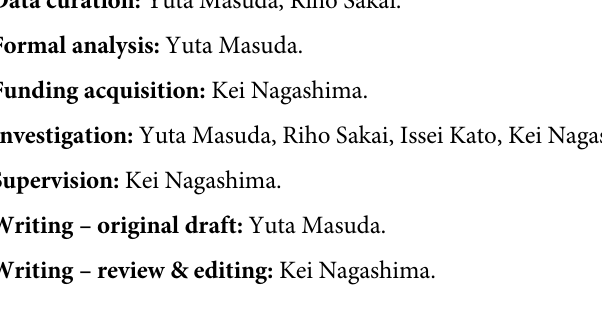
S1 Fig. Photoimages of cFos expression in the VMPO, MnPO, and MPO of the hypothala- mus in the CON and CAP groups in Experiment 2. S1 Table. Abdominal temperature in the CON and CAP groups in Experiment